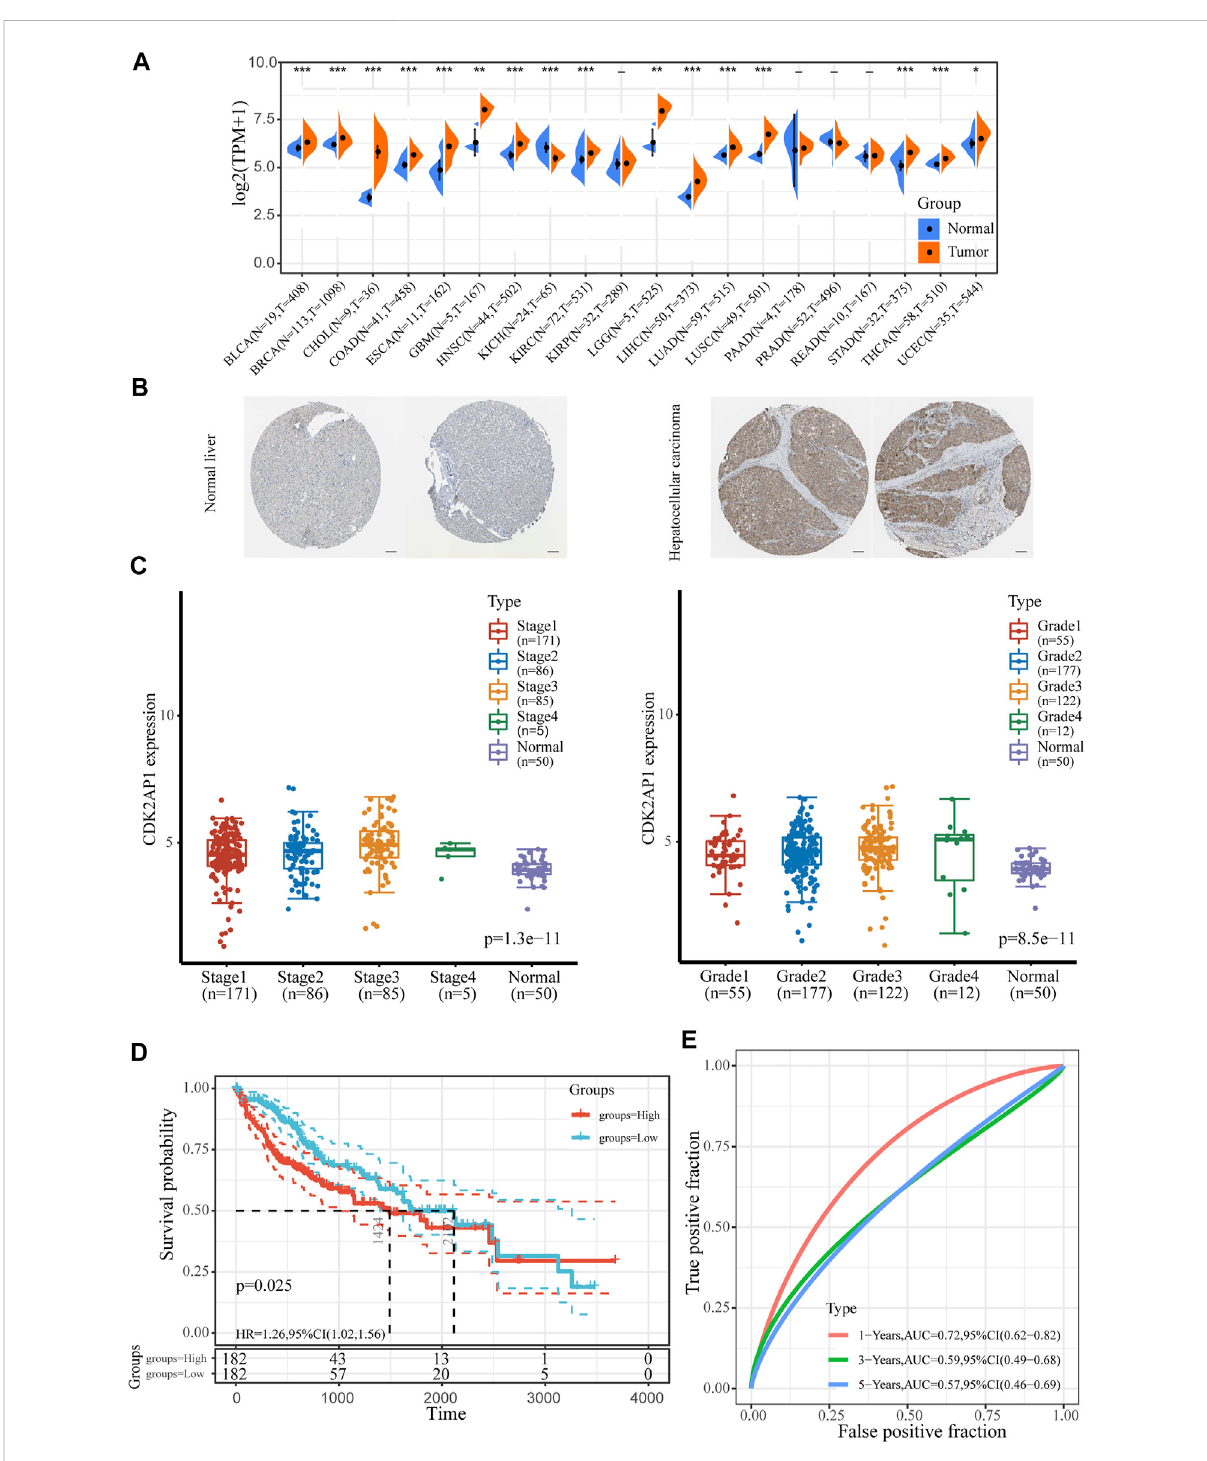
FIGURE 1 The expression level of CDK2AP1 in LIHC (A) Pan-cancer analysis of the expression of CDK2AP1 (B) The expression of CDK2AP1 protein in normal liver and hepatocellular carcinoma tissues was observed by immunohistochemistry using HPA database. Scale bars, 100 μ m (C) CDK2AP1 expression was signi fi cantly correlated with clinical stage and histologic grades (D) Patients with high expression of CDK2AP1 had inferior OS than those with low expression of CDK2AP1 (E) ROC curves of CDK2AP1 . * p < 0.05, ** p < 0.01 and *** p <